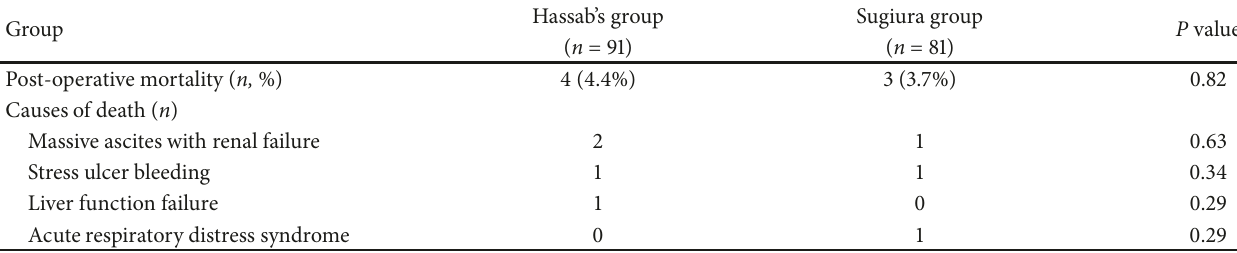
Table 2: Perioperative incidence and causes of mortality.